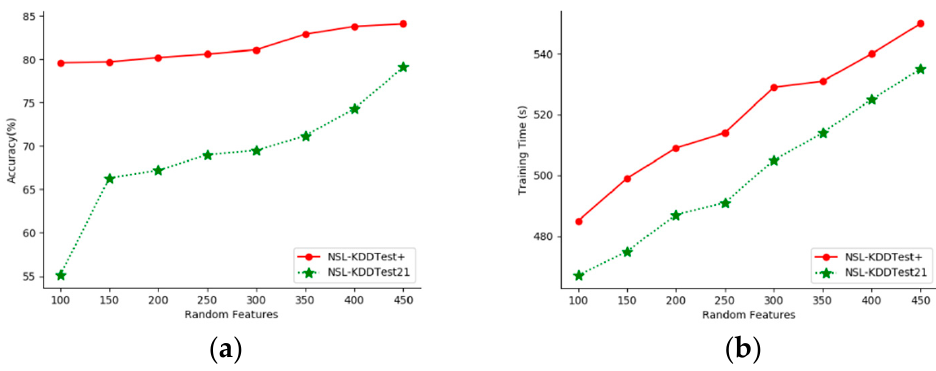
Figure 5. Experimental results with random features from 100 to 450. ( a ) Accuracy. ( b )Training time.